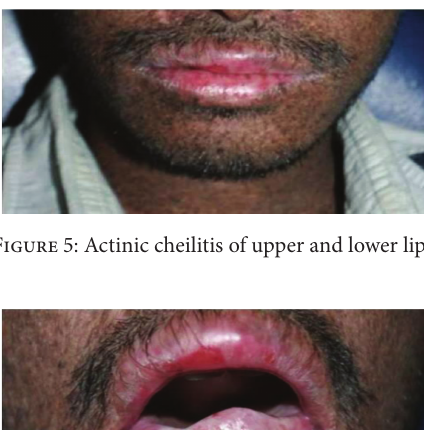
apoptosis leading to loss of neurons [18]. The neurological